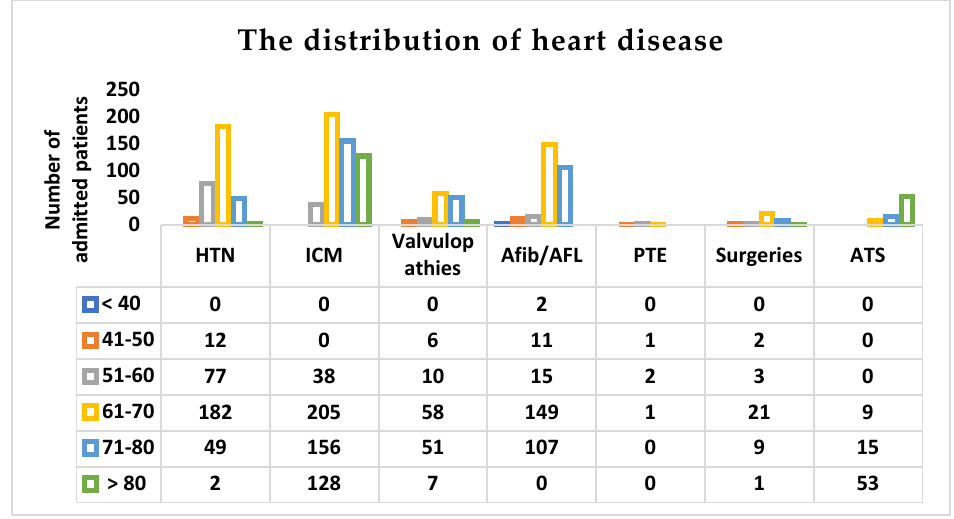
Figure 3 . Graphical representation of the distribution of cardiovascular diseases compared to age groups for N-COV BATCH. HTN—arterial hypertension, ICM—ischemic cardiomyopathy, Afib— atrial fibrillation, AFL—atrial flutter, PTE—pulmonary thromboembolism, ATS—atherosclerosis.